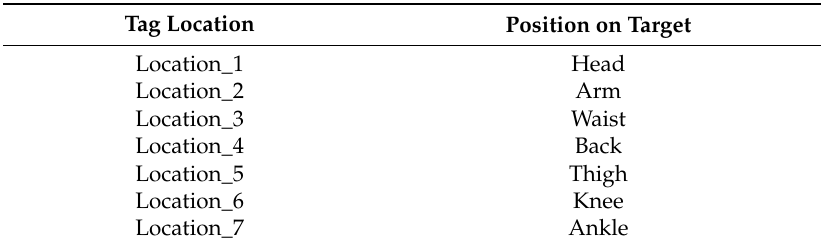
Table 1. Distribution of tag placement on the